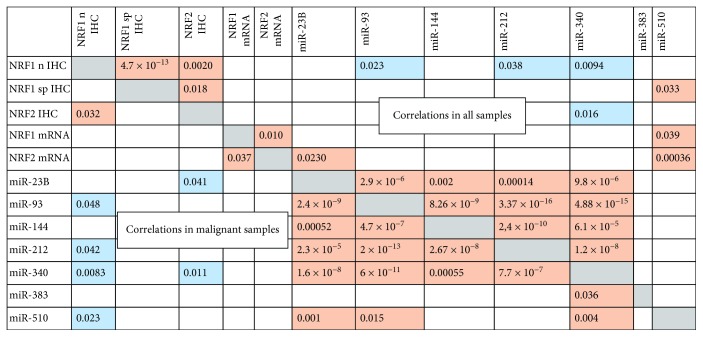
Significant correlations between studied parameters in all samples (top) and in malignant samples (bottom), p value. Blue box indicates negative and brown box positive correlation.